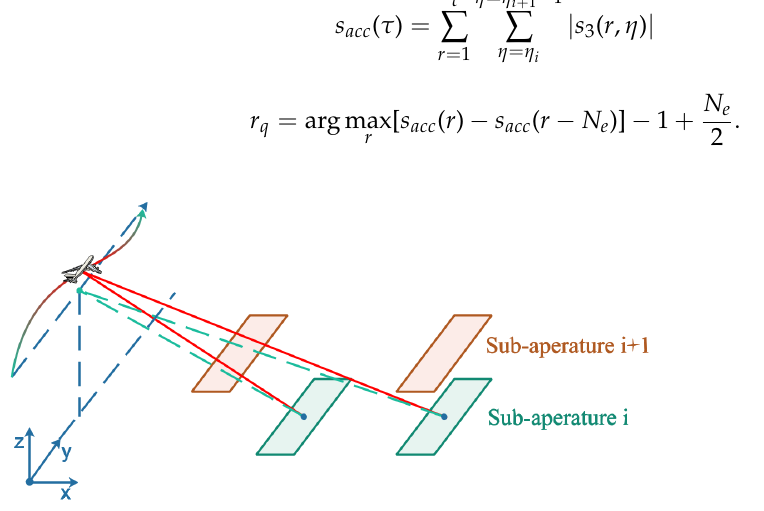
Figure 5. Range-variant residual RCM